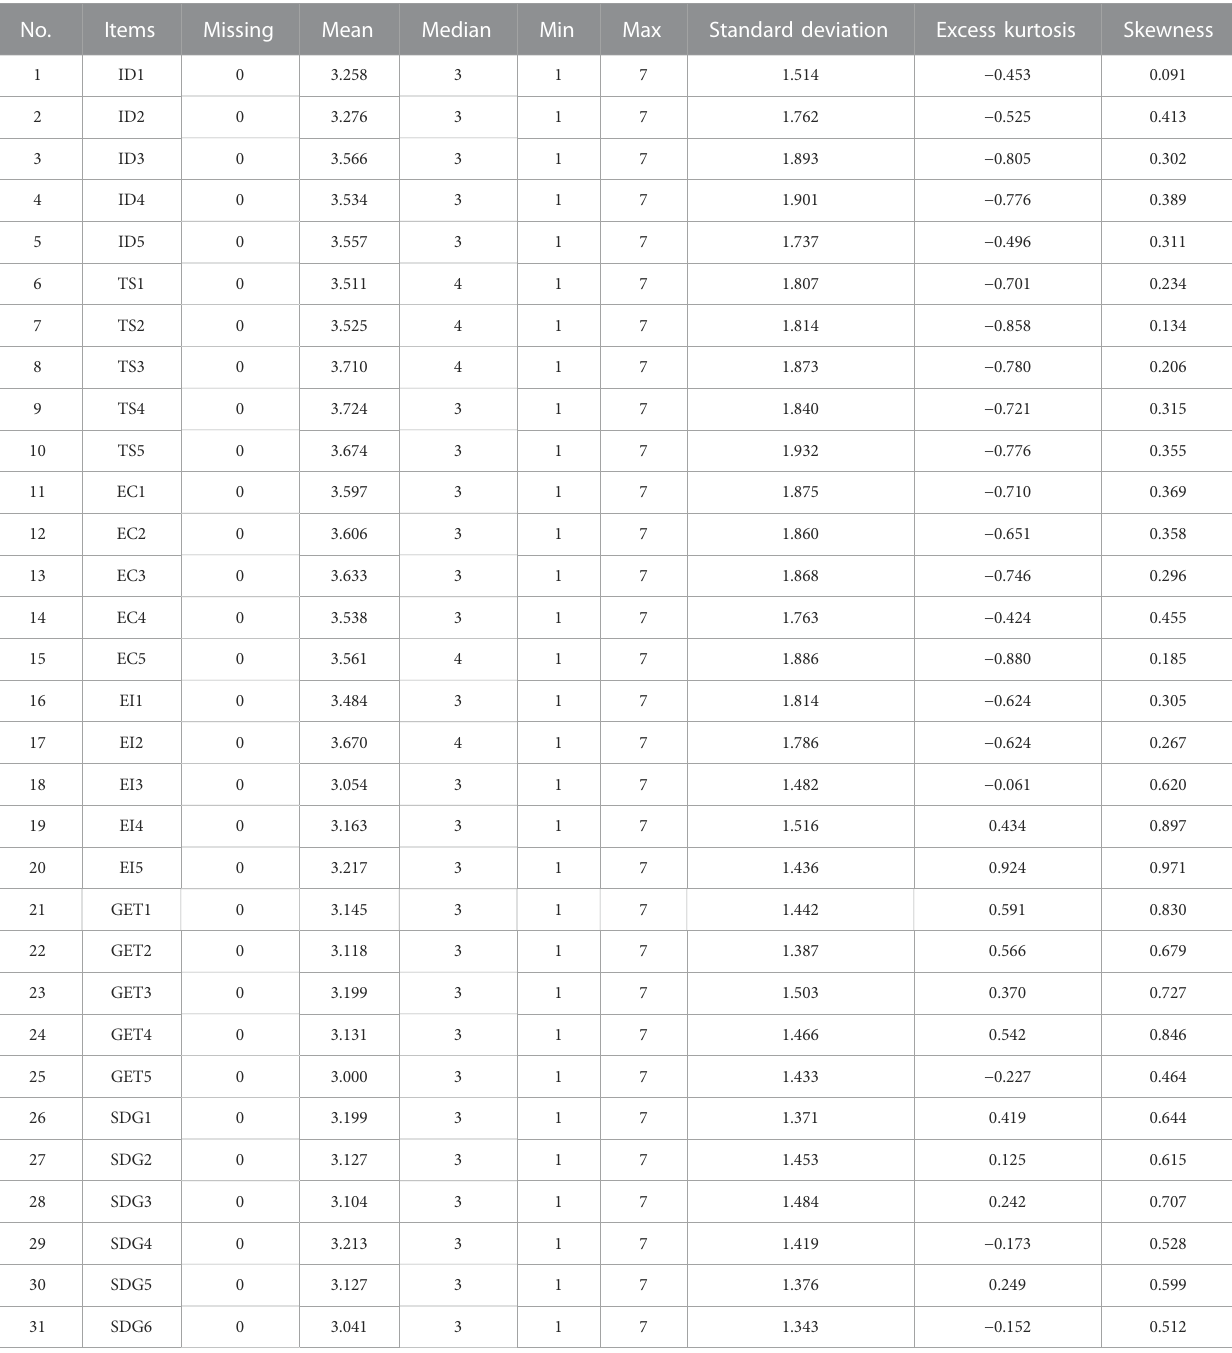
TABLE 2 Normality